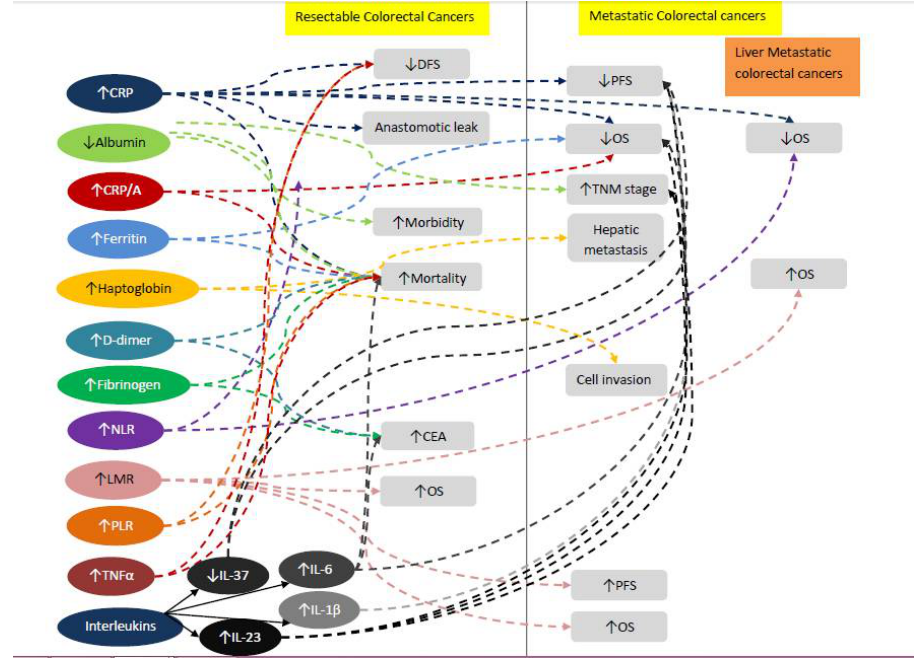
Figure 2. Current evidence correlating inflammatory biomarkers to survival and outcomes in resectable and metastatic colorectal cancers. NLR: neutrophil to lymphocyte ratio; LMR: lymphocyte to monocyte ratio; PLR: platelet to Lymphocyte ratio.